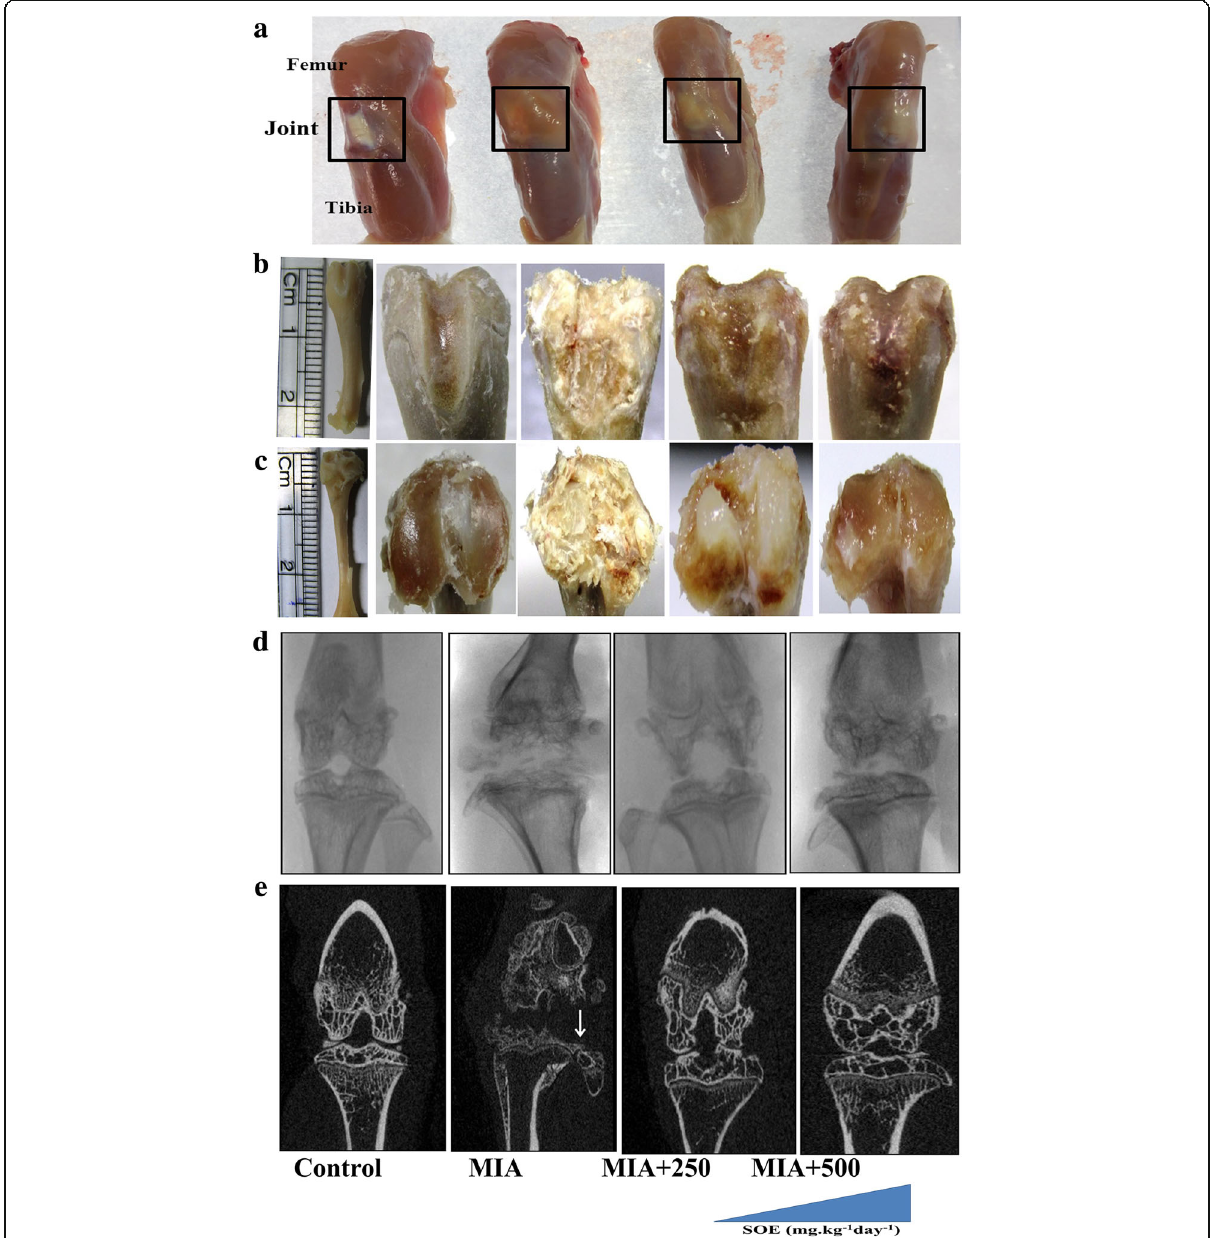
Fig. 3 Effect of SOE treatment at articular and sub-chondral bone. a Images of excised knee from various groups showed morphological changes in different treated groups. b and c macroscopic photographs of femur and tibia respectively after termination of study. d Radiographic images of various groups and ( e ) 2D micro-CT images of knees. There was significant cartilage loss and sub-chondral bone parts in MIA-injected group (marked with an arrow). Treatment with SOE ameliorates articular